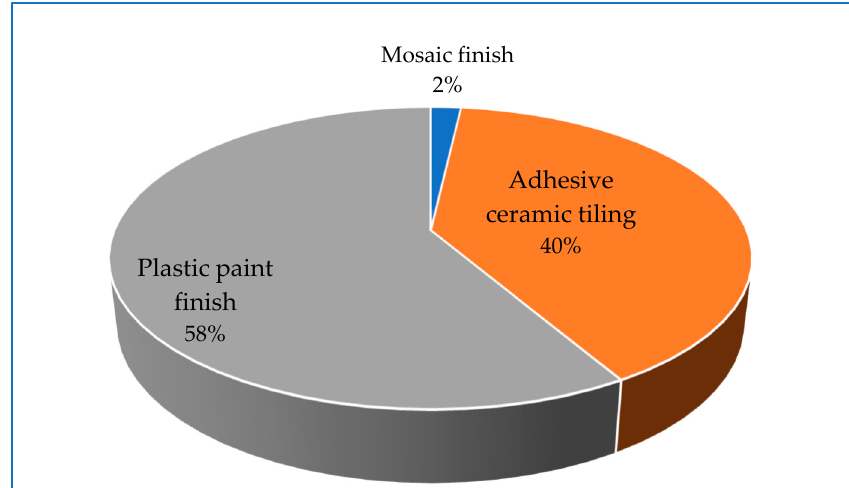
Figure 10. Proportion of the types of finishes with swelling defect.